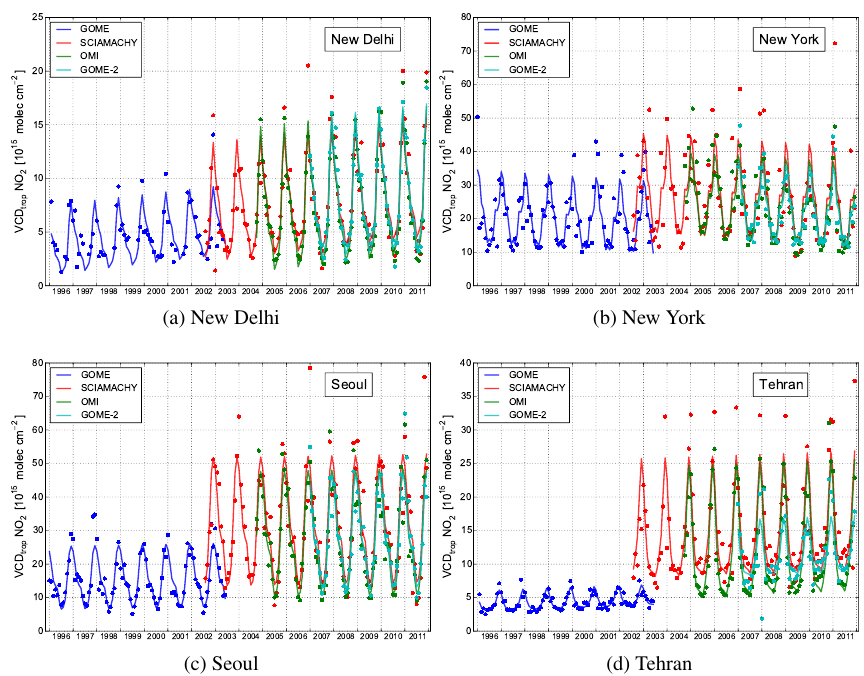
Fig. 18 : Measured monthly average VCD trop NO 2 (dots) and fitted trend function from the multi-instrument trend model (lines) for the four instruments GOME (blue), SCIAMACHY (red), OMI (green), and GOME-2 (cyan).